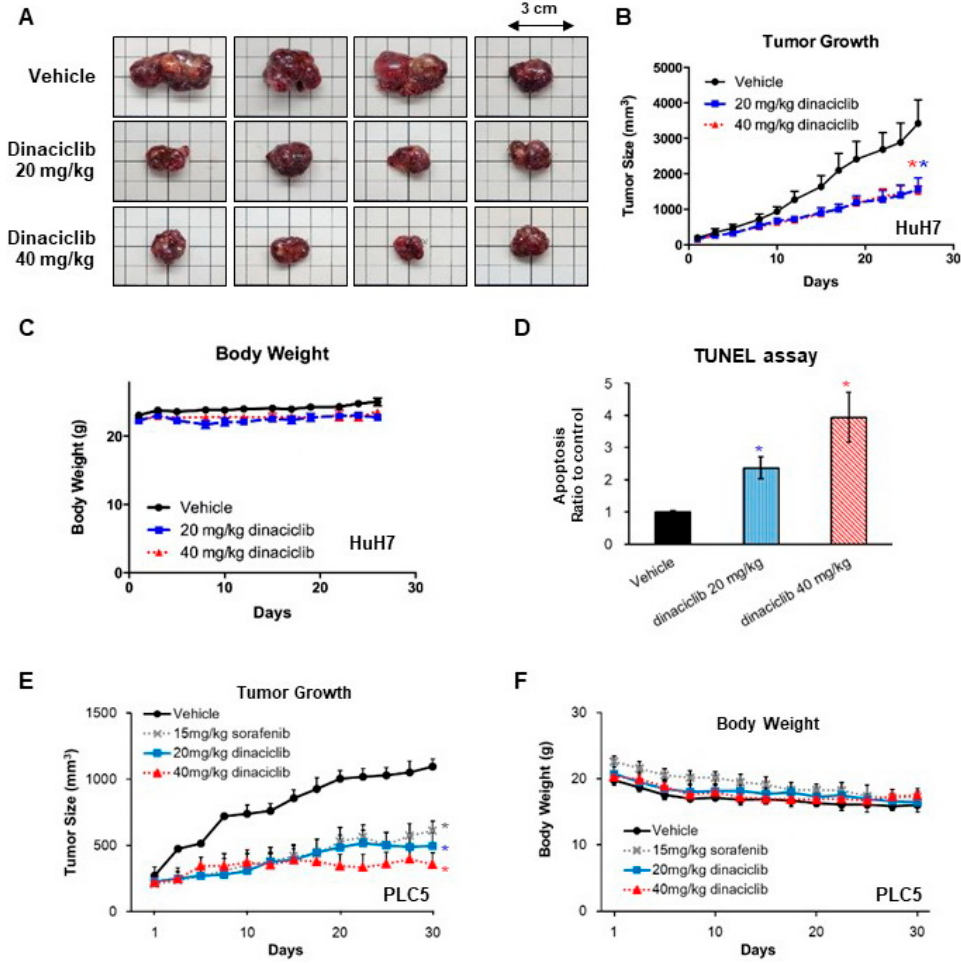
Figure 4. Xenograft studies. ( A – D ) Mice were subcutaneously injected with HuH7 cells. Treatment